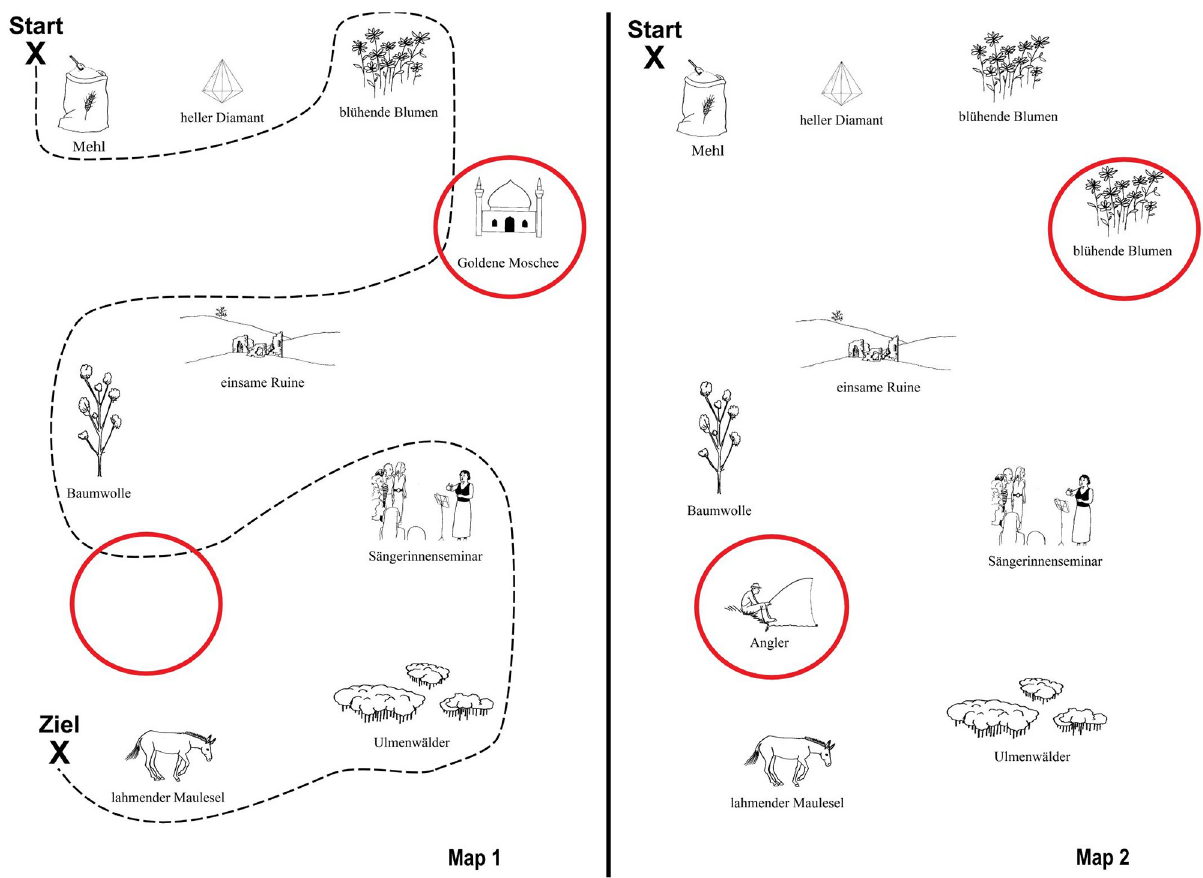
Fig 1. Example of map task materials. The instruction giver’s map, with a route leading from “Start” (top left) to “Ziel” (finish; bottom left), is in the left panel. Mismatches between maps are highlighted with red circles.